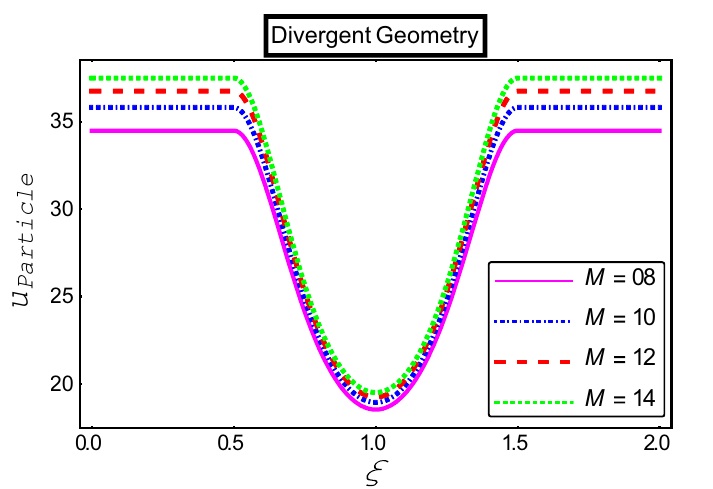
Figure 9. Impact of Hartmann numbers on particle